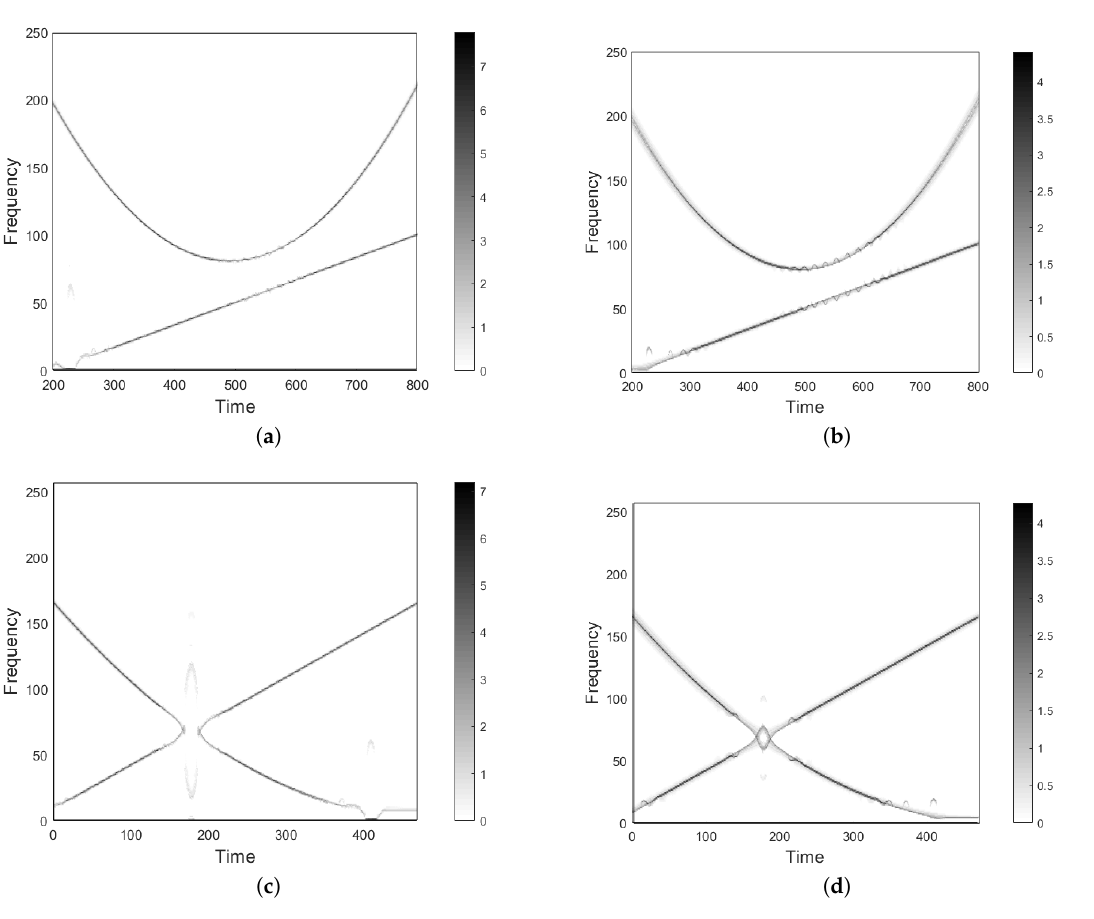
Figure 9. ( a ) Reassigned spectrogram of the signal in Figure 1 using FIRST , where the number of iterations depends on the value of the spectrogram at the initial point. ( b ) Reassigned spectrogram of the same signal using FIRST_K . ( c ) Reassigned spectrogram of the signal in Figure 2 using FIRST , where the number of iterations depends on the value of the spectrogram at the initial point. ( d ) Reassigned spectrogram of the same signal using FIRST_K . As it can be observed, except for the central part, points in the interference regions are correctly reassigned even by FIRST_K , which is a less refined iterative method.